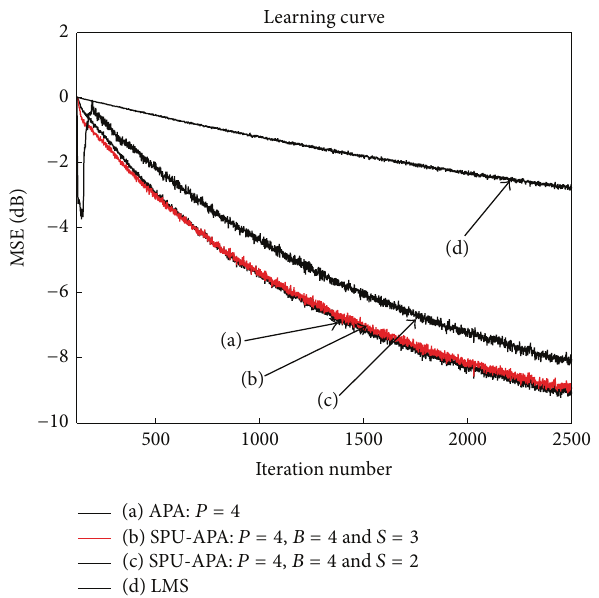
Figure 4: Learning curves for the LMS, APA, and SPU-APA with 𝜇 = 10 −9 for LMS, 𝜇 = 0.1 and 𝑃 = 4 for APA, and 𝜇 = 0.1, 𝑃 = 4, 𝐵 = 4, and 𝑆 = 2, 3 for SPU-APA.